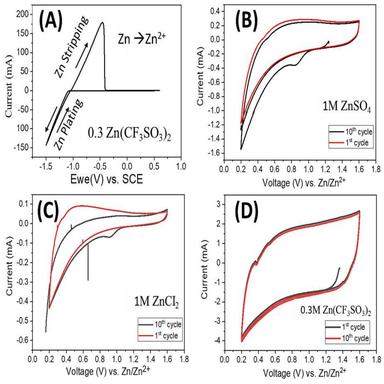
(A) CV graph of the metallic Zn working electrode in 1 M ZnSO4 aqueous electrolyte at a scan rate of 10 mV/s. And CV voltammograms of hemp-based pyrolyzed carbon material in (B) 1 M ZnSO4, (C) 1 M ZnCl2 and (D) 0.3 M Zn(CF3SO3)2 aqueous electrolytes at a scan rate of 10 mV/s.